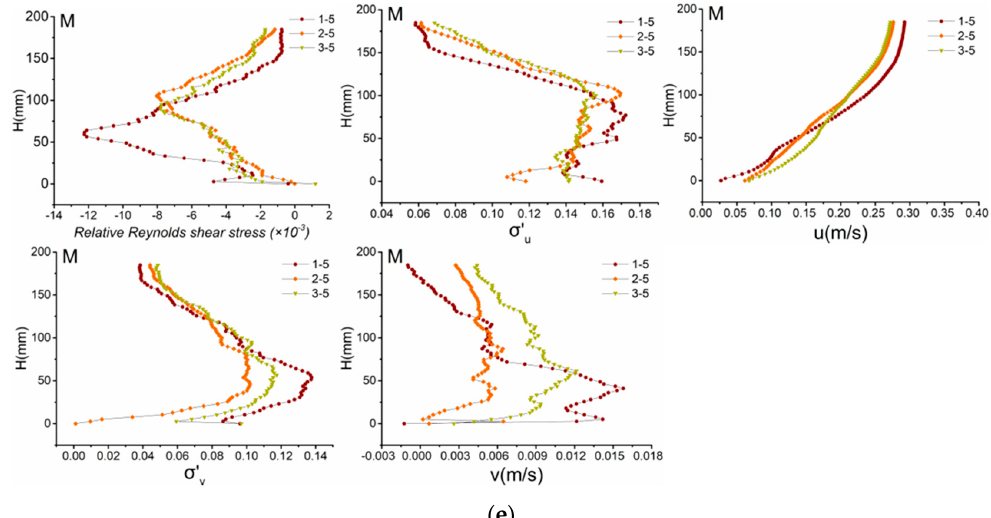
Figure 11. Reynolds shear stress, longitudinal turbulence intensity, longitudinal velocity, vertical turbulence intensity and vertical velocity at selected ( a ) Section A; ( b ) Section C; ( c ) Section D; ( d ) Section G; and ( e ) Section M.